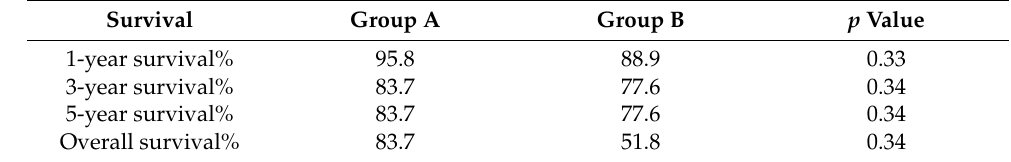
Table 3. Survival after heart